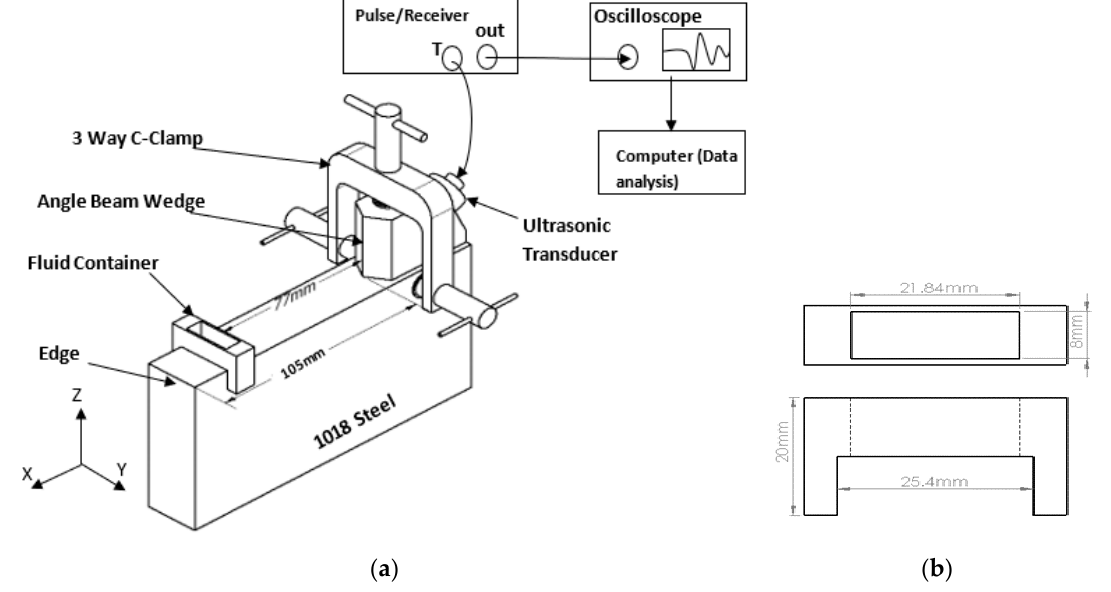
Figure 3. ( a ) Schematic diagram for the experiment setup; ( b ) The container dimensions used in this study.